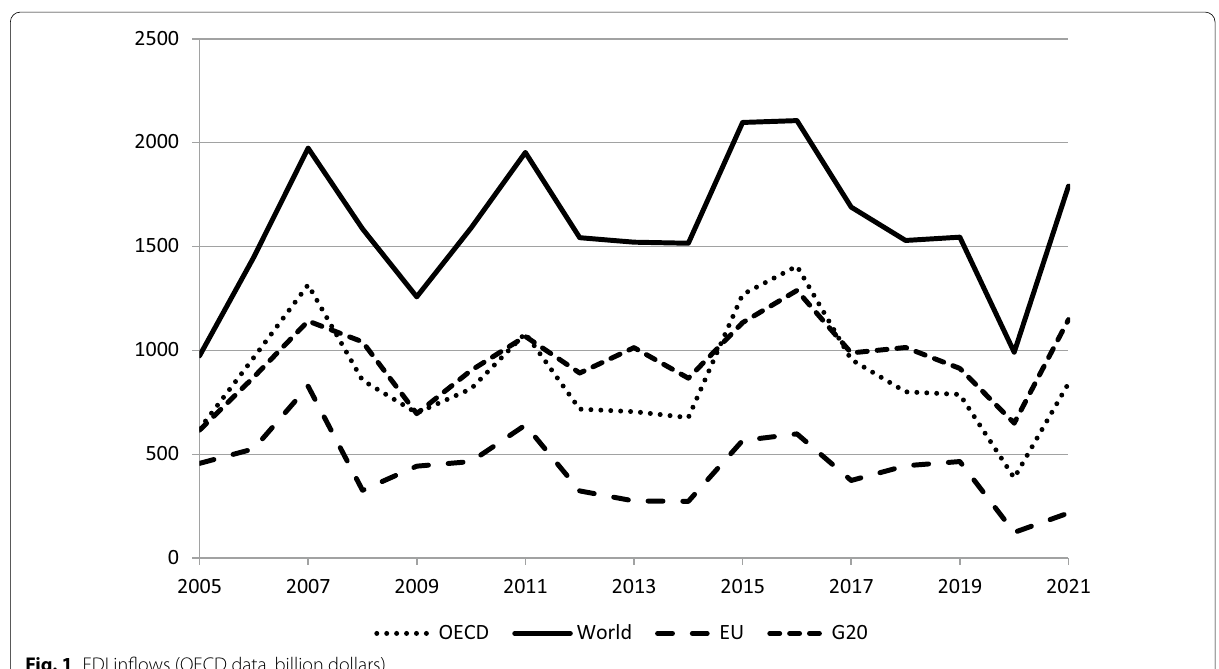
Fig. 1 FDI inflows (OECD data, billion